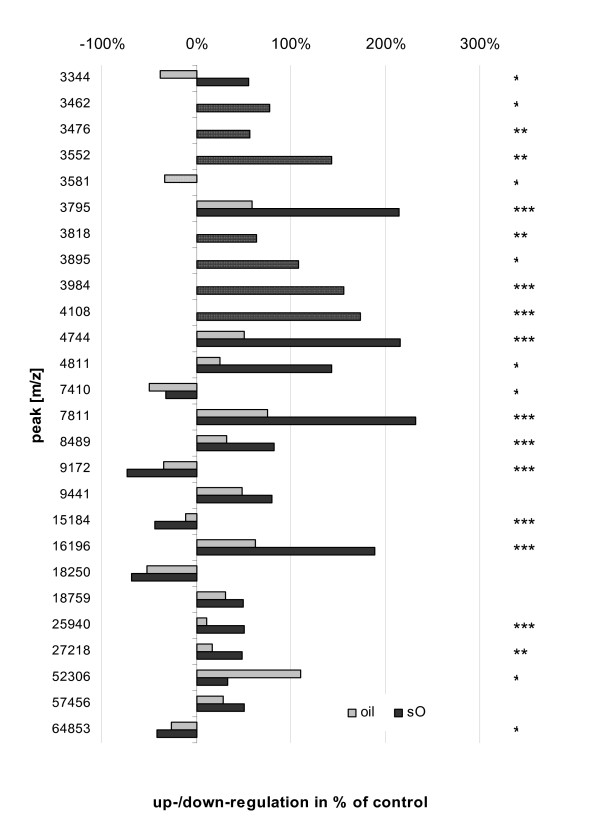
Relative expression changes of differentially expressed peptides and proteins in the digestive gland of Blue mussels following 21d exposure to 0.5 mg/L crude oil (oil) and 0.5 mg/L crude oil spiked with a mixture of APs and PAHs (0.1 mg/L; sO) in % of control intensity; *, significantly different at 0.05 ≥ p ≥ 0.01, **, at 0.01 ≥ p ≥ 0.001, ***, at p < 0.001. Dotted bars indicate differential expression occurring in one of two exposures only.